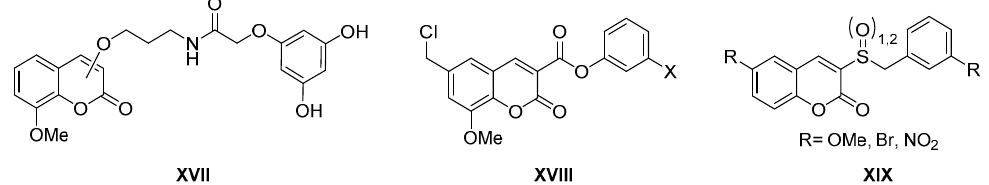
Figure 4. Structures of coumarin derivatives as antioxidant and anti-inflammatory agents.